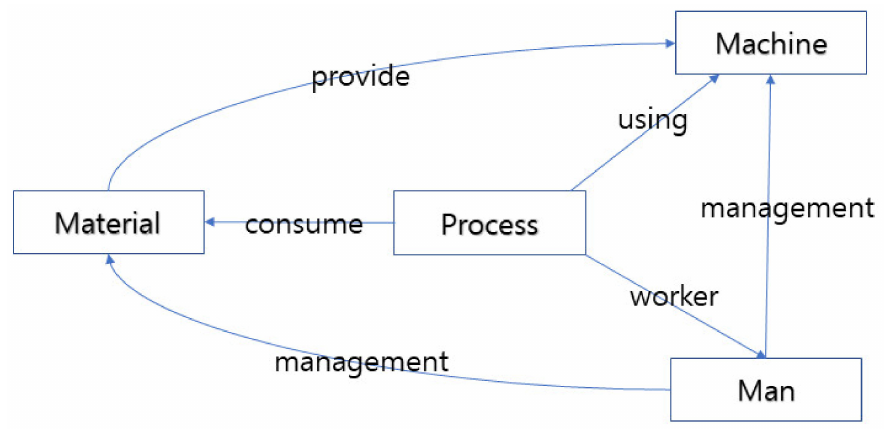
Figure 6. Process and 4M